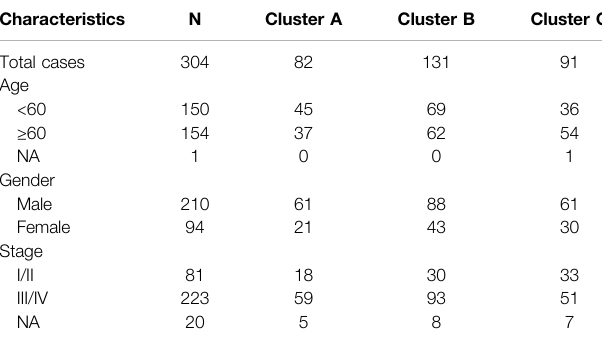
TABLE 1 | Characteristics of patients in cluster A, B, and